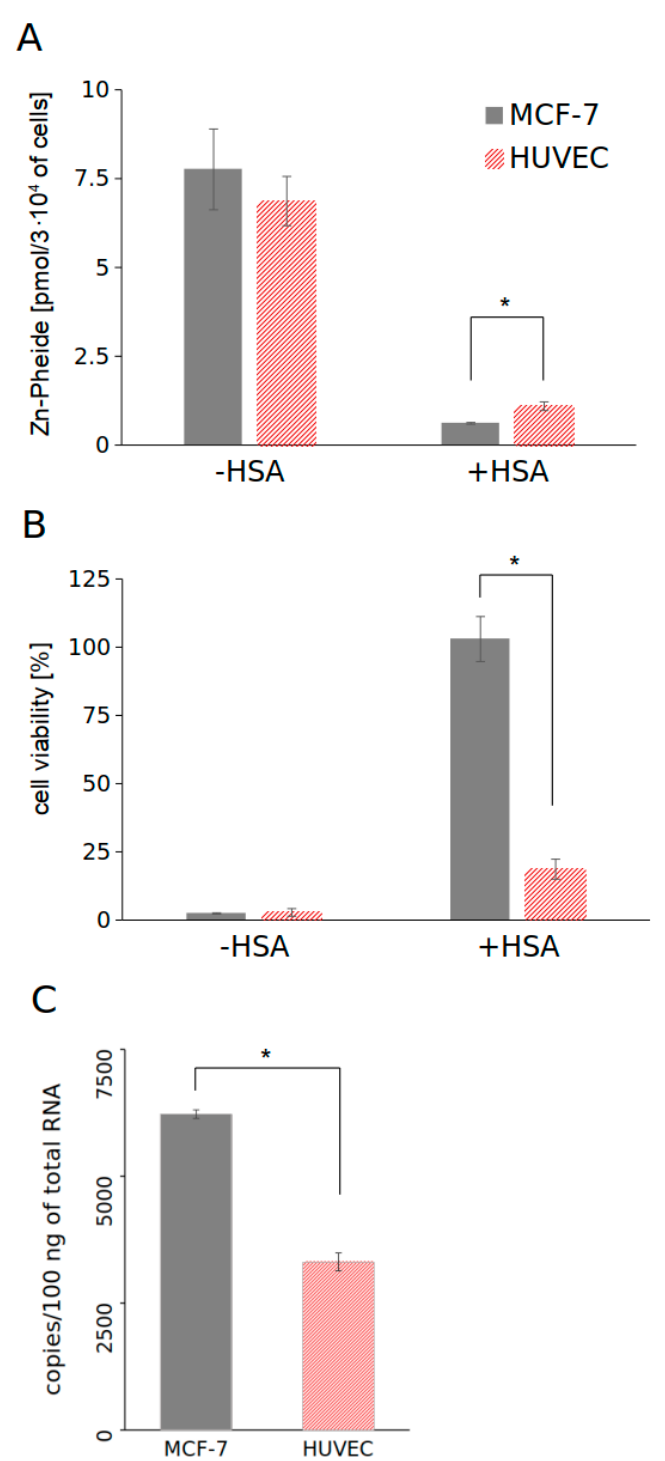
Figure 2. Comparison of cellular accumulation of Zn-Pheide ( A ), cell viability after Zn-Pheide- induced PDT ( B ), and expression of the ABCG2 gene ( C ) in MCF-7 and HUVEC cells. Cellular accumulation of the PS and cell viability after PDT were measured in the presence and absence of HSA (250 µ M). The concentration of Zn-Pheide in both experiments was equal to 1 µ M. Expression of BCRP was determined by quantitative real-time PCR. Data are presented as mean ± SD, n = 3. Significant differences between HUVECs and MCF-7 cells are indicated by asterisks (*), p <